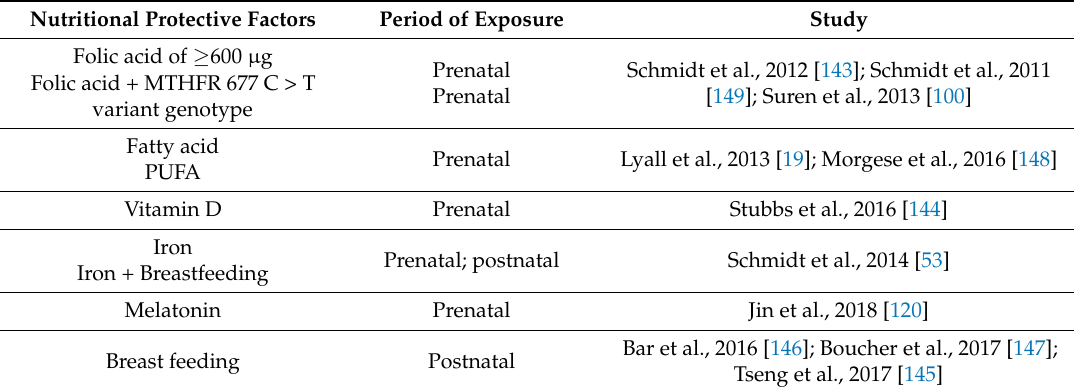
Table 2. Proposed protective factors for